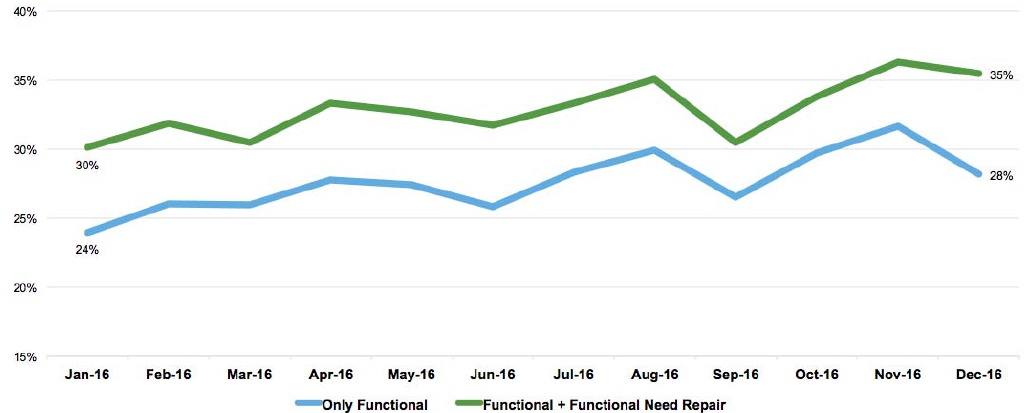
Figure 10. Functionality of water points in Bunda, showing a steady increase over the year 2016.